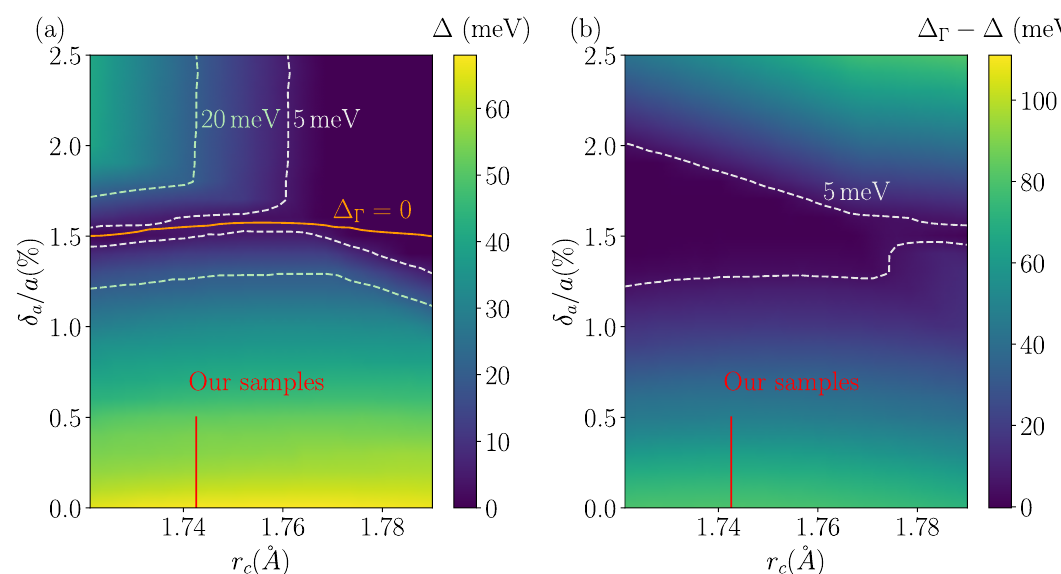
Figure 5: Left: Fundamental band gap in the phase space of the Van der Waals gap r and uniaxial strain ( δ α ). Dashed curves are isocontours of ∆ while the continuous curve indicates ∆ Γ = 0. Right: Difference between the fundamental gap and the gap at Γ . Dashed lines correspond to